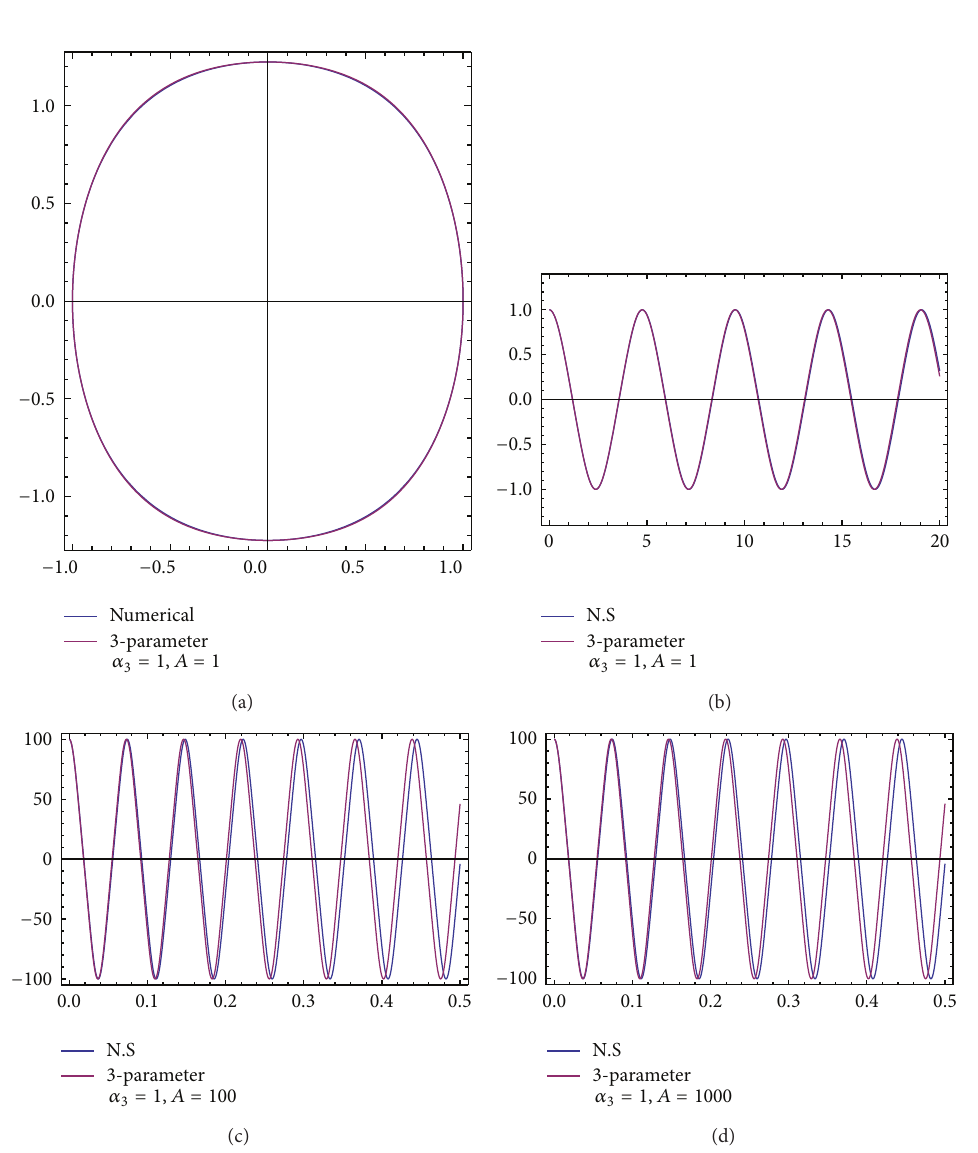
Figure 1: (a) Comparison for the 𝑢 versus ̇𝑢 trajectory for the case of 𝐴 = 1 , (b) 𝑡 versus 𝑢 (displacement 𝐴 = 1 ), (c) 𝑡 versus 𝑢 (displacement 𝐴 = 100 ), (d) 𝑡 versus 𝑢 (displacement 𝐴 = 1000